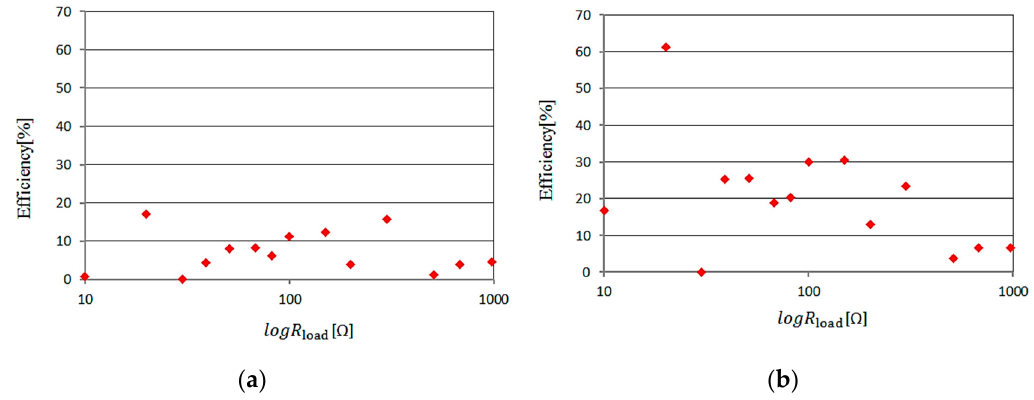
Figure 9. Measurement output voltage versus input RF signal. ( a ) Input voltage is 50 mV ( b ) input voltage 100 mV.